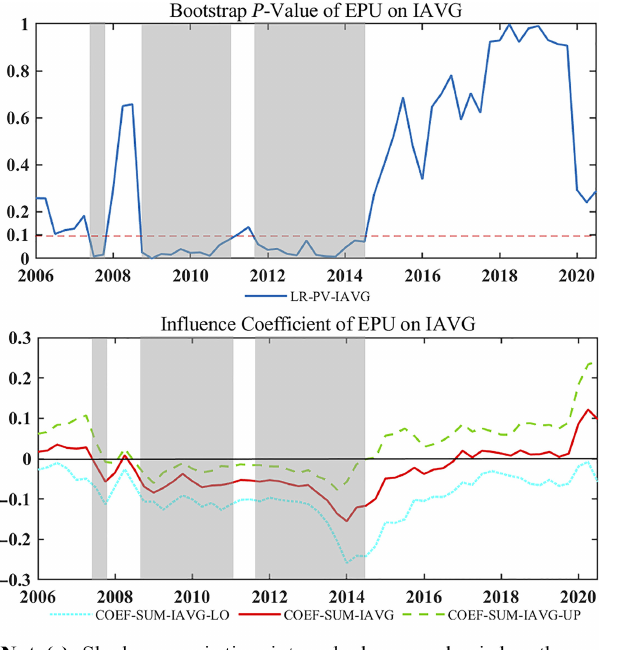
Figure.1. Sub-sample bootstrap rolling window causality test of EPU on